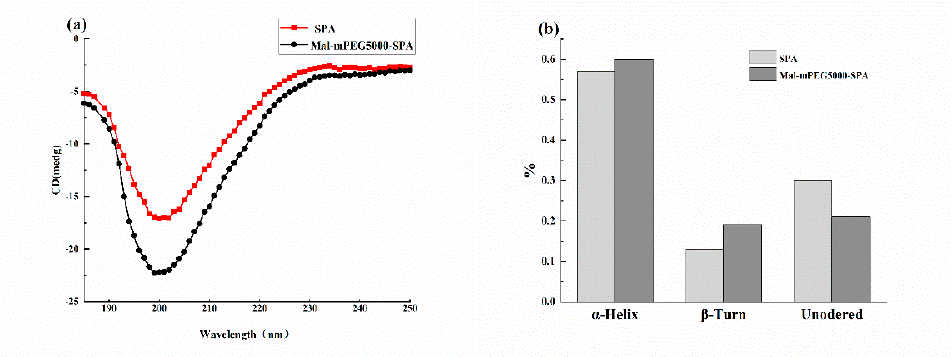
Figure 2. Circular dichromatogram ( a ) and the secondary structure ( b ) of SPA and Mal − mPEG5000 − SPA.